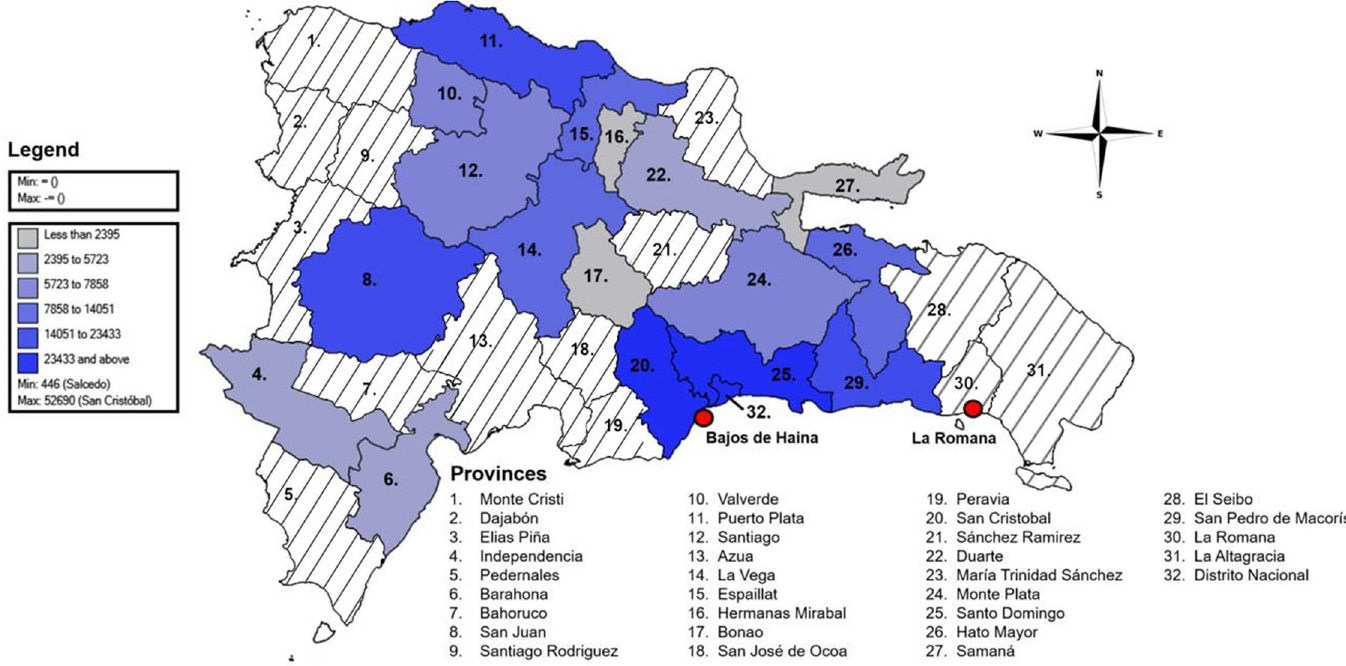
Fig 1. Distribution of total suspected cases of CHIKF reported in the Dominican Republic by province. A suspected case was definedby the presence of sudden fever and arthralgia.The color scheme classifies provincesby number of total suspected CHIKF cases, determinedby summing the numberof cases reportedin MSP DIGEPI weekly bulletinsand ChikungunyaOutbreak Bulletinsfor each epidemiologicalweeks betweenFebruary 16, 2014 and June 6, 2015. No exact case numbers were reportedto MSP DIGEPI for provincesshaded in white. Number 32, Distrito Nacional,represents the nationaldistrict, which does not pertain to a province. The city of La Romanaand the port of Bajos de Haina, where the outbreakis suspectedto have started, are highlighted in red. Map created using Epi Info TM 7.1.5 software licensedby the Centers for Disease Control and Prevention(http://wwwn.cdc.gov/epiinfo/7/). MSP DIGEPI weeklybulletinspubliclyavailablethrough Minesteriode Salud Publica (http://digepisalud.gob.do/).